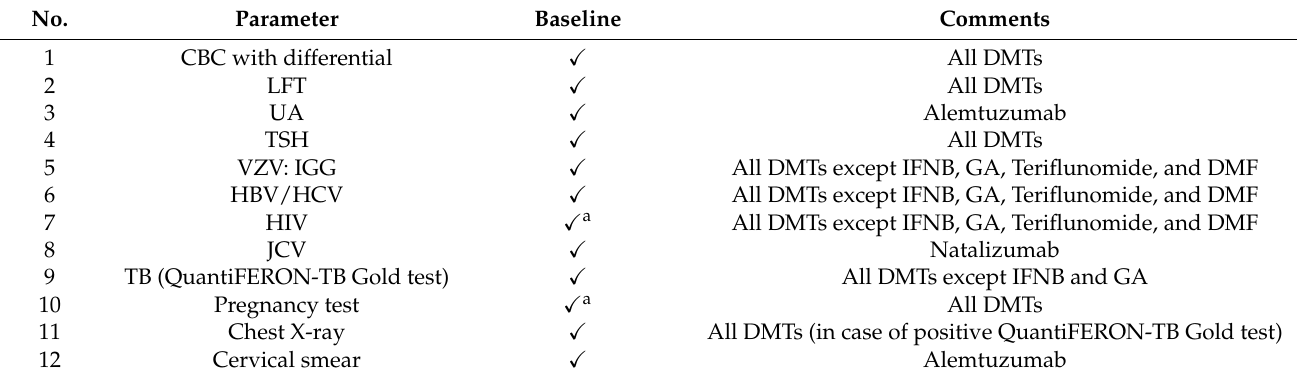
Table 2. Baseline investigations before initiation of a disease-modifying treatment (DMT).